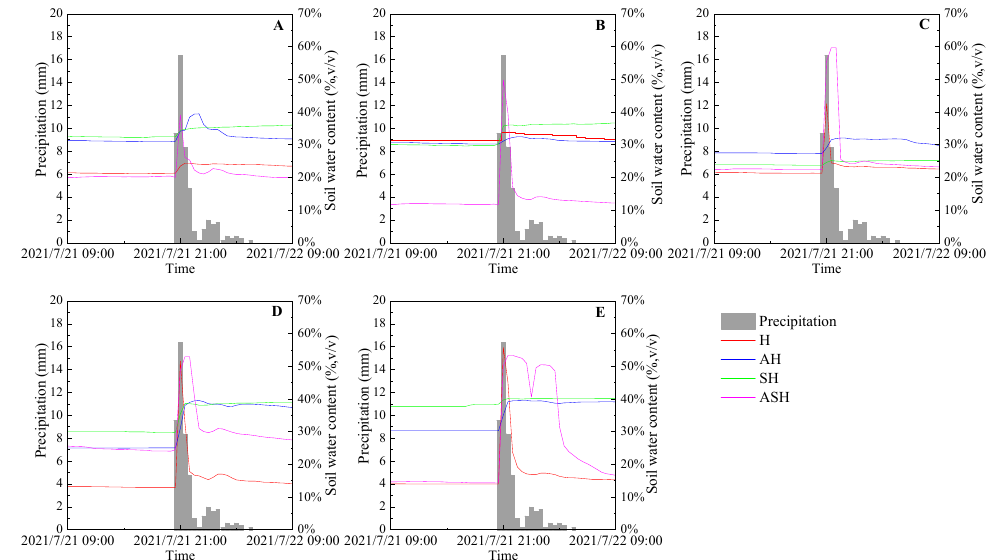
Figure 7. The variations of soil moisture content at heavy rain event. (A) 0 – 10 cm, (B) 10 – 20 cm, (C) 20 – 30 cm, (D) 30 – 50 cm, (E) 50 – 70 cm.